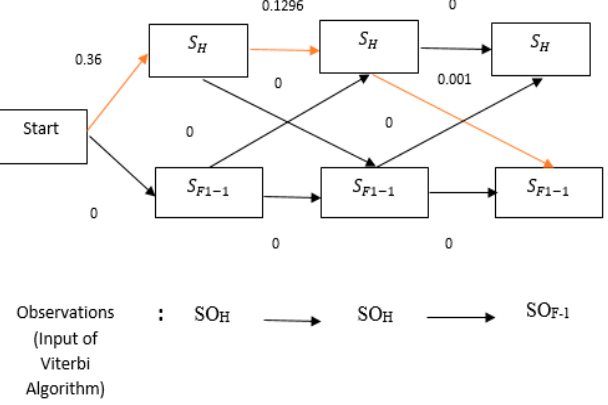
Figure 22. Example of Viterbi algorithm.